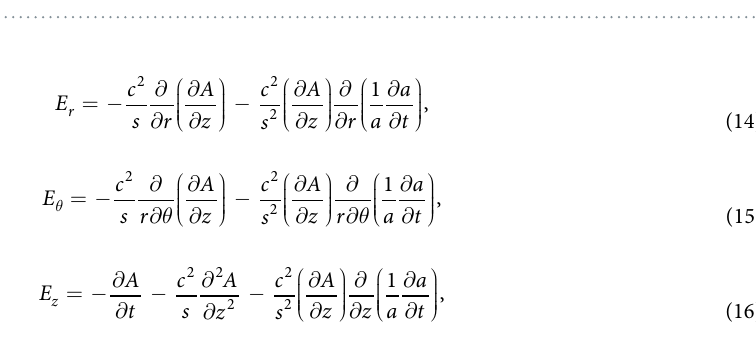
Figure 3. Surface plots of the initial ( t = 0) intensity profiles in the focal plane ( z = 0) of the magnetic field components given by Eqs (21 and 22). ( a – d ) cB E / l = 0,1,2 and 5, respectively. The parameters used are: L = 1.5 λ 0 , w 0 = 0.8 λ 0 , λ 0 = 1 μ m, n 0 = 0, ϕ 0 = 0 and k r = x 1, l / w 0 , where x 1, l is the first zero of J l ( x